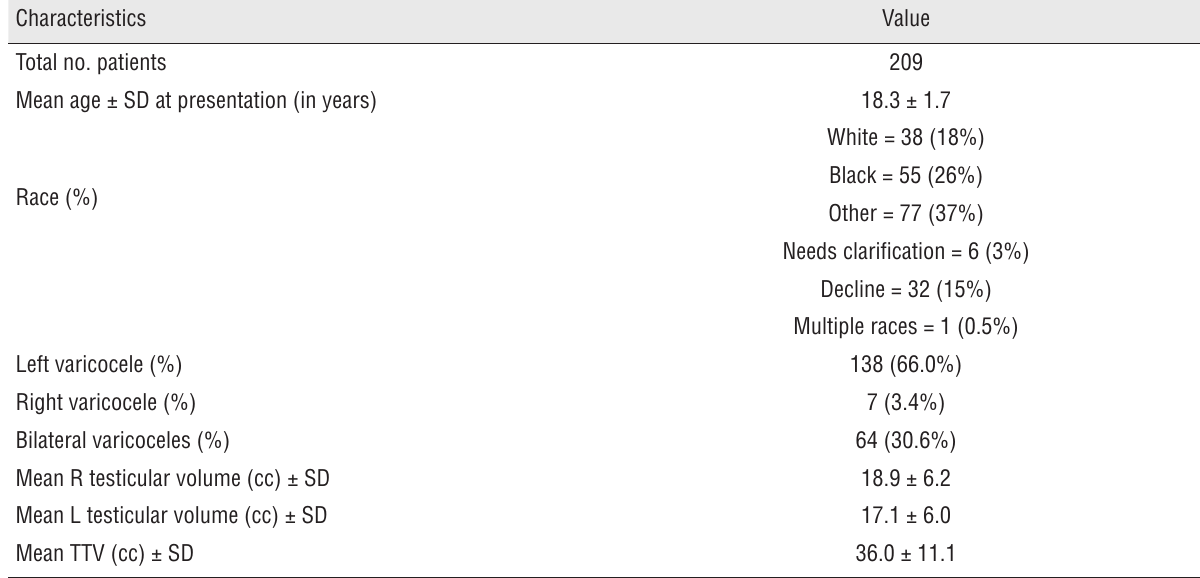
Table 1 - Baseline demographic characteristics of patients who met the inclusion criteria.